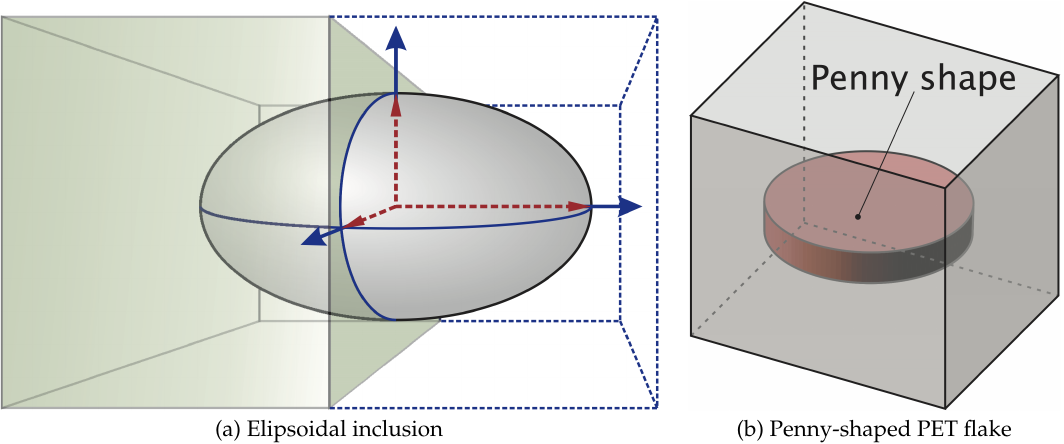
Fig. 1. Inclusion in infinite matrix.